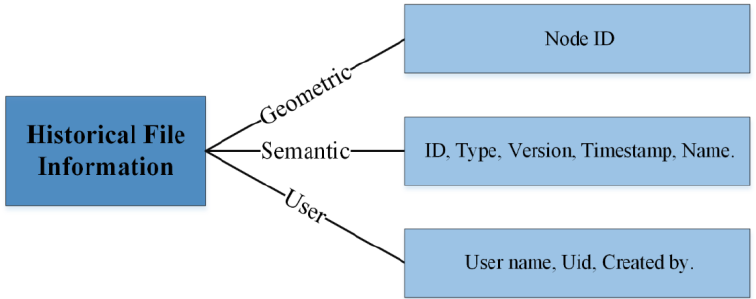
Figure 2. Category of information in the OSM history file.